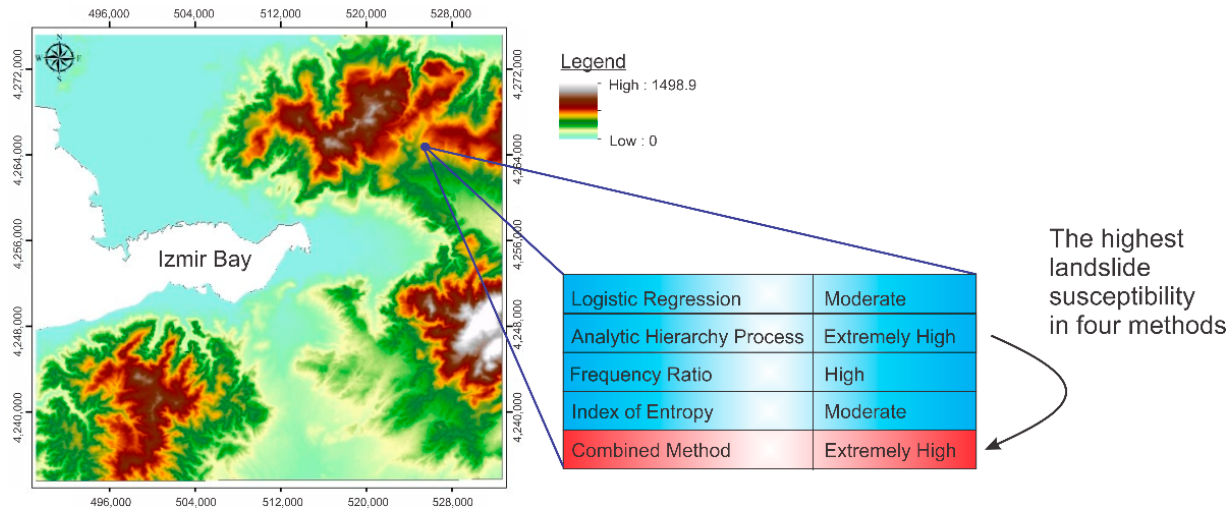
Figure 6. Details of the combined method, highest susceptibility class out of four methods is as- signed.